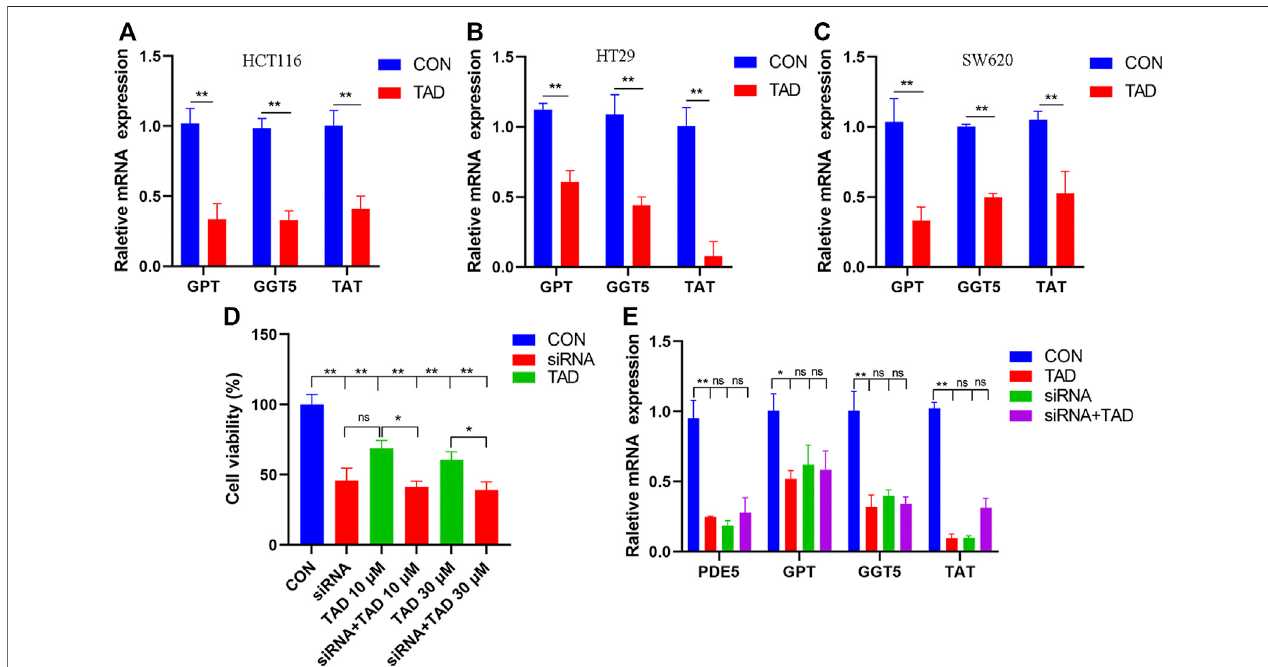
FIGURE8| Changesofimportantgenesinaminoacidmetabolismandtargetoftadala fi l. (A) HCT116cellviabilityafter10 μ Mtadala fi ltreatmentfor24 h. (B) HT29 cell viability after 10 μ M tadala fi l treatment for 24 h. (C) SW620 cell viability after 10 μ M tadala fi l treatment for 24 h. (D) Cell viability analysis when pde5 was knocked down by siRNA. (E) Expression of GPT, GGT5 and TAT after tadala fi l treatment with or without pde5 knockdown.